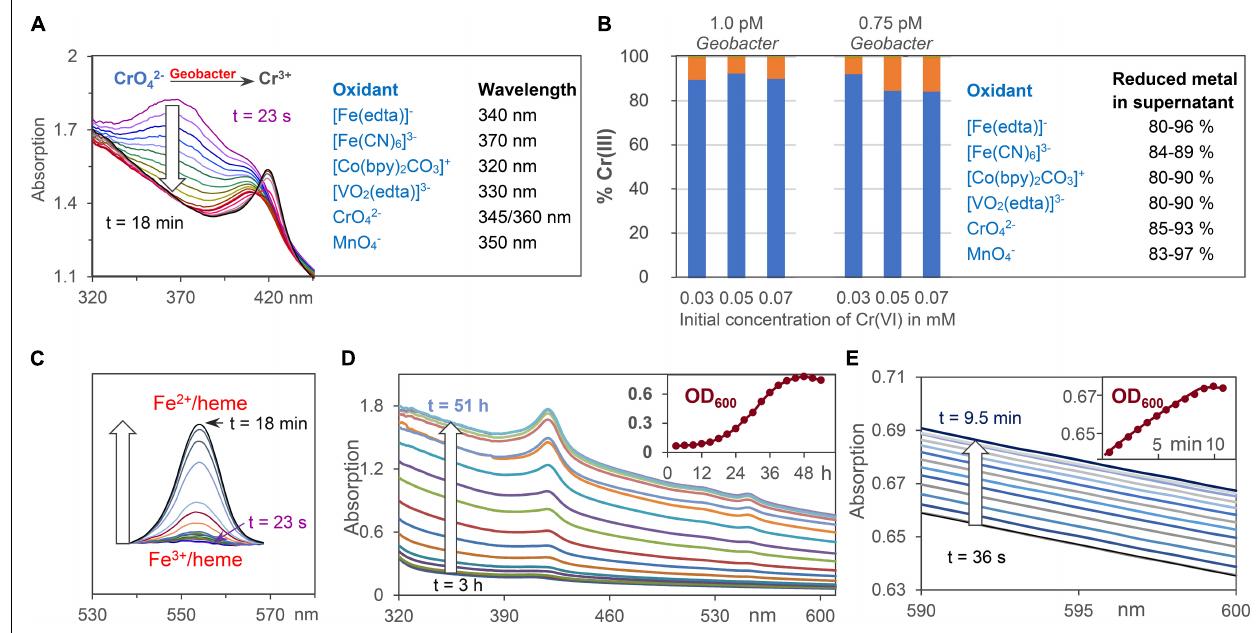
FIGURE 2 | Analytical tools for the analysis of extracellular metal ion, Fe 2 + /heme, and cell concentrations. (A) Reduction of oxidizing metals salts by G. sulfurreducens by time dependent UV/Vis spectroscopy at wavelengths where product absorptions are negligible. CrO 42 − respiration is shown as an example. (B) ICP analysis of Cr 3 + ions outside of the cell (blue) and at the cell membrane (orange) after reduction of CrO 42 − . Percentage data for reduced metal salts in the supernatant are given. (C) Changes of Fe 2 + /heme concentration during respiration using the areas of Q-bands. (D) Increase of UV/Vis absorptions during bacteria growth with fumarate as intracellular oxidant. The insert shows scattering increases at 600 nm (OD 600 ) during 2 days of cell growth. (E) UV/Vis absorptions during cell growth using low chromate concentrations for G. sulfurreducens respiration, starting from the resting